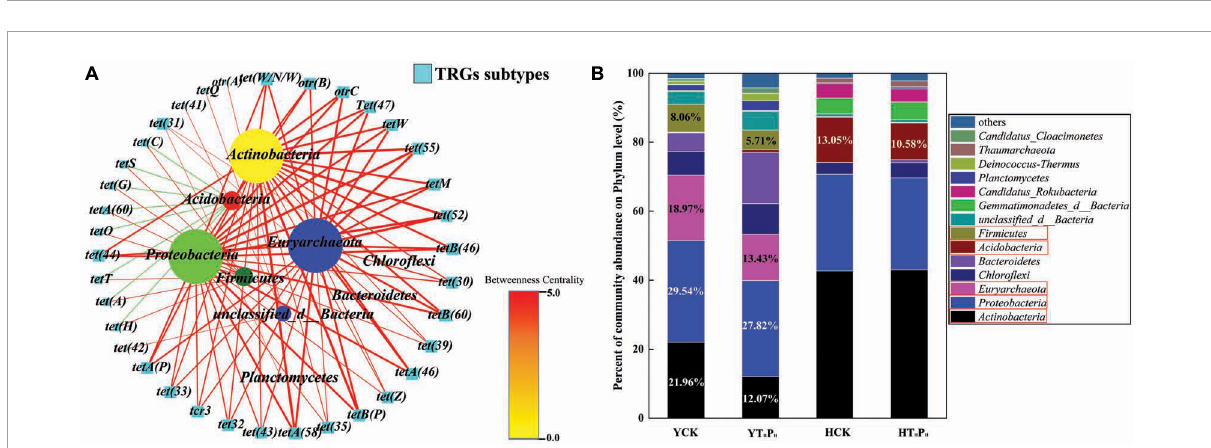
FIGURE7 Network analyses among the TRGs, samples, and bacterial community across: YCK, HCK, YT H P H , and HT H P H . (A) TRGs-bacterial community network analyses. Red and green edges represent the positive and negative correlations, respectively. The network graphs were displayed with Cytoscape 3.5.2 in Prefuse Force Directed Layout by Betweenness centrality. (B) Distribution histograms of the bacteria with TRGs at the phylum levels. YCK means the pig farm sediments alone treated for 30 days, HCK means the riverbed sediments alone treated for 30 days, YT H P H means the pig farm sediment system contain 180 mg · L - 1 of TC and 125 mg · kg - 1 of g-C 3 N 4 for 30 days, HT H P H means the riverbed sediment system contain 180 mg · L - 1 of TC and 125 mg · kg - 1 of g-C 3 N 4 for 30 days.